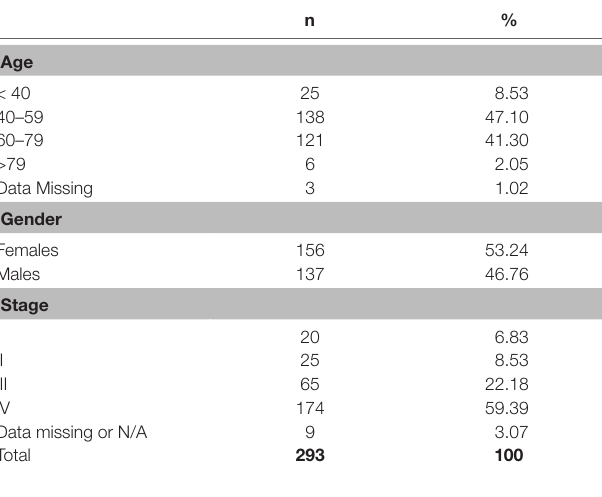
TABLE 1 | Age, gender, and cancer stage distribution of study